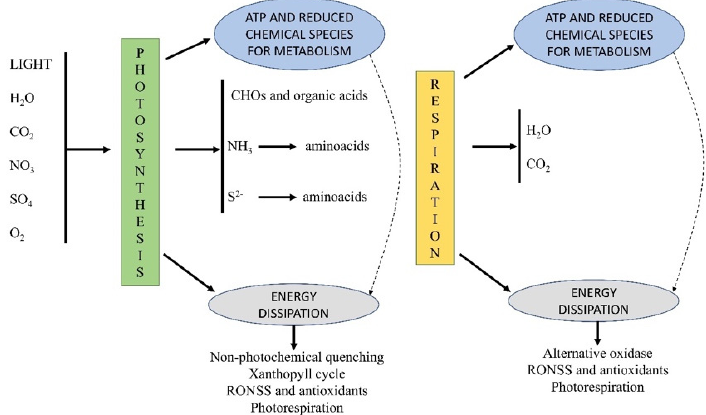
Figure 2. Model of different energy capture and dissipation processes. Both photosynthesis and res- piration, as well as the metabolism coupled with these activities, constitute dissipative mechanisms. Photosynthesis and respiration are further associated with other photochemical and biochemical energy dissipation pathways, including the production of RONSS. During the abiotic evolutionary process and later during the early biotic evolution, the production of RONSS went from being only a mechanism for the dissipation of free energy, with the consequent generation of entropy, also